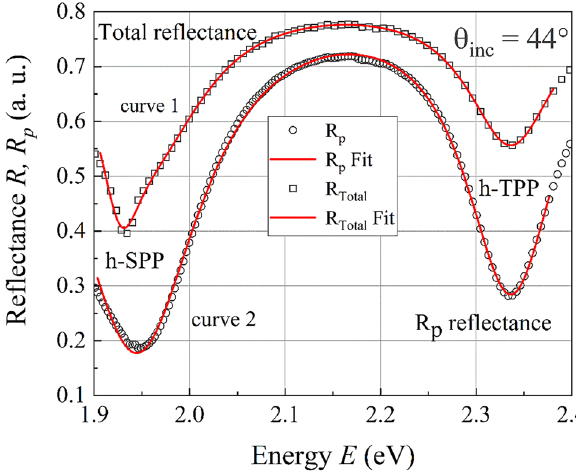
Figure 4: The hybrid TPP-SPP mode experimental (curve 2) TM-polarization reflection spectra and the total reflectance (curve 1) for the angle of incidence θ = 44 ° . The red curves are the fi tting results.